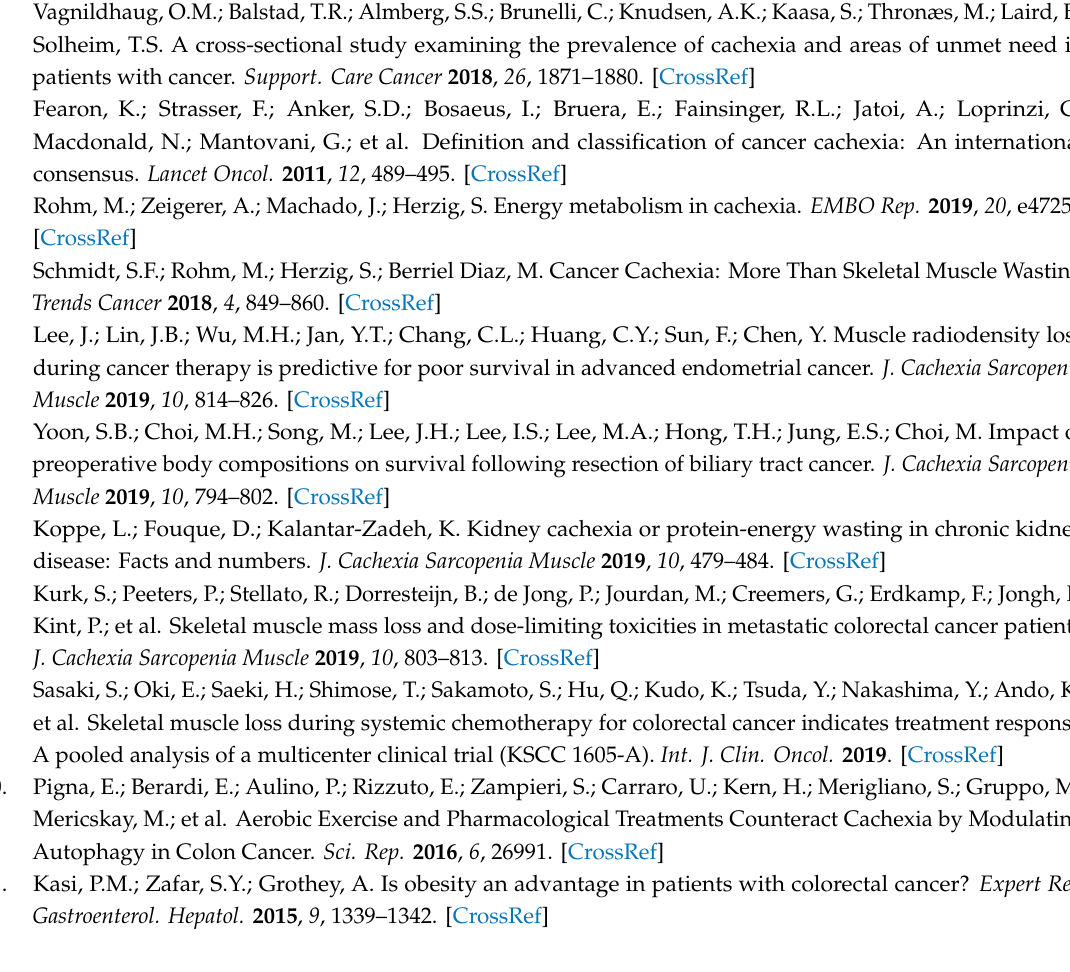
Table S1: Spearman correlations for metabolites overlapping across GC–MS and 1 H-NMR*; Table S2: Comparison of metabolite levels across cachectic, pre-cachectic, and non-cachectic patients by tumor stage. One-way ANOVA was used to assess the p for di ff erence across the three